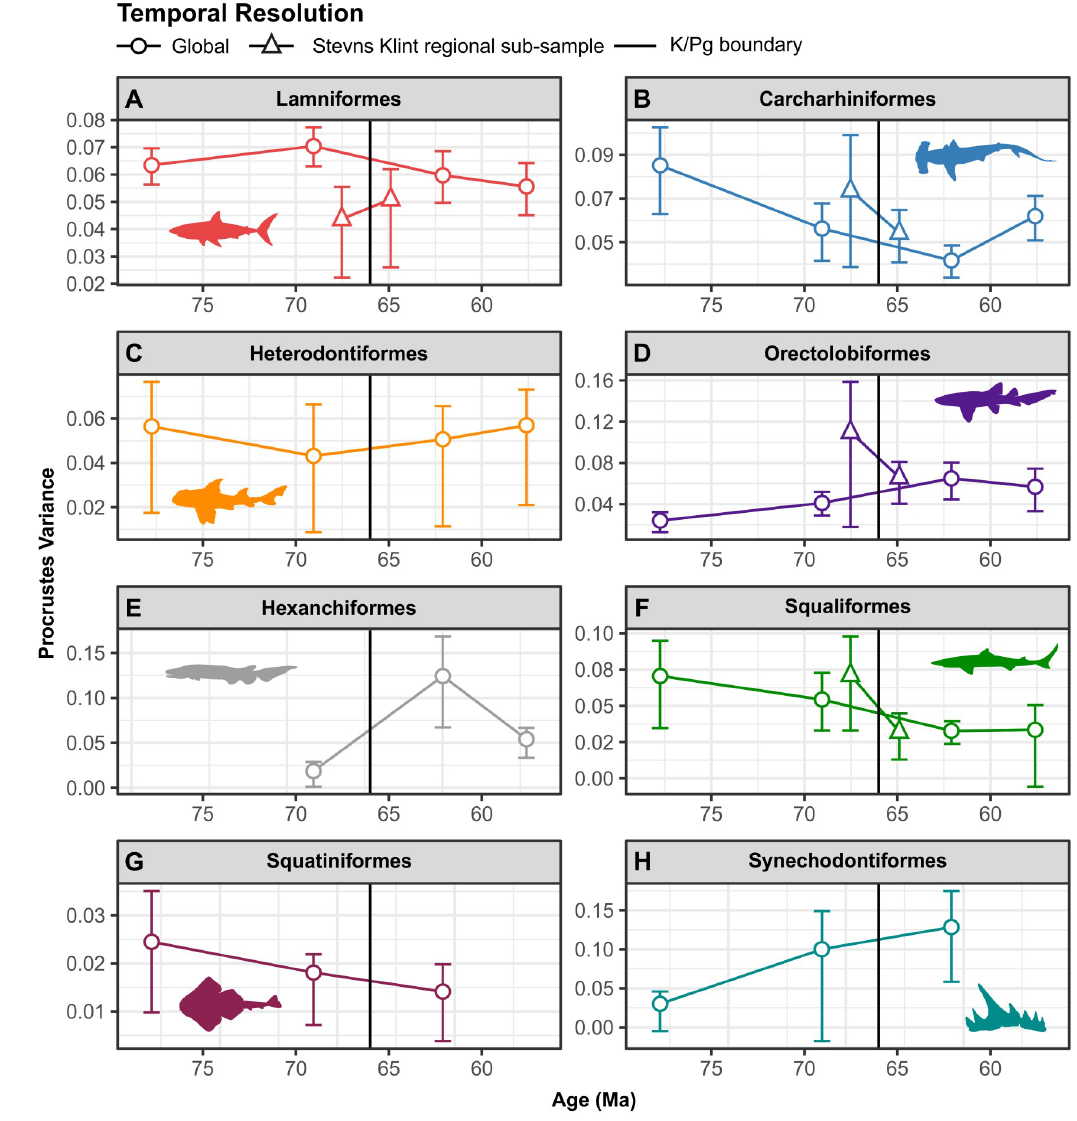
Fig 4. Global and regional clade-specific (order-level) disparity profiles. (A–D) Temporal resolution varies between groups but broadly tracks the time-binned K/Pg interval. Clade-level subsampling is shown in Tables C and D in S1 Text. Silhouette graphics created by MB and Julius Csotonyi (https://csotonyi.com/). The data used in this analysis can be accessed online at https://doi.org/10. 5061/dryad.c866t1g5n. K/Pg, Cretaceous/Paleogene; Ma, million